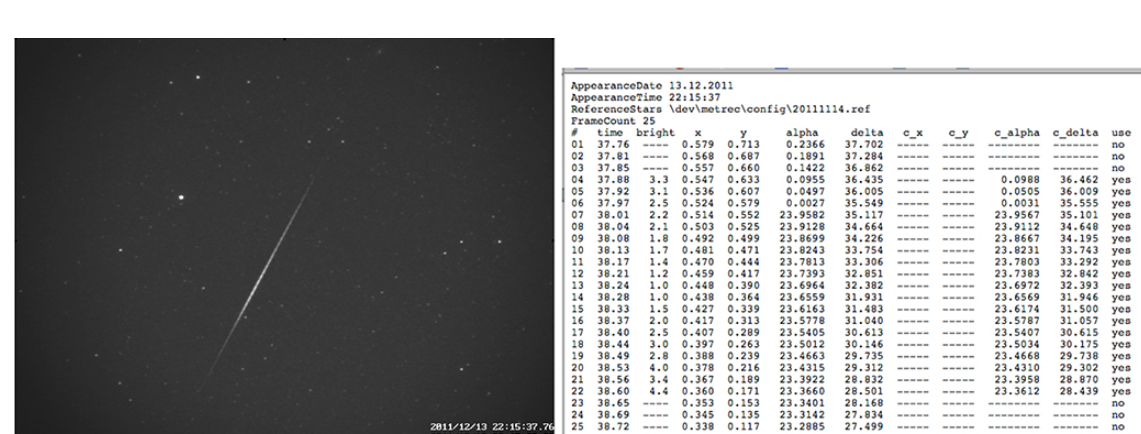
Fig. 8. A typical meteor image and the corresponding *.inf file.